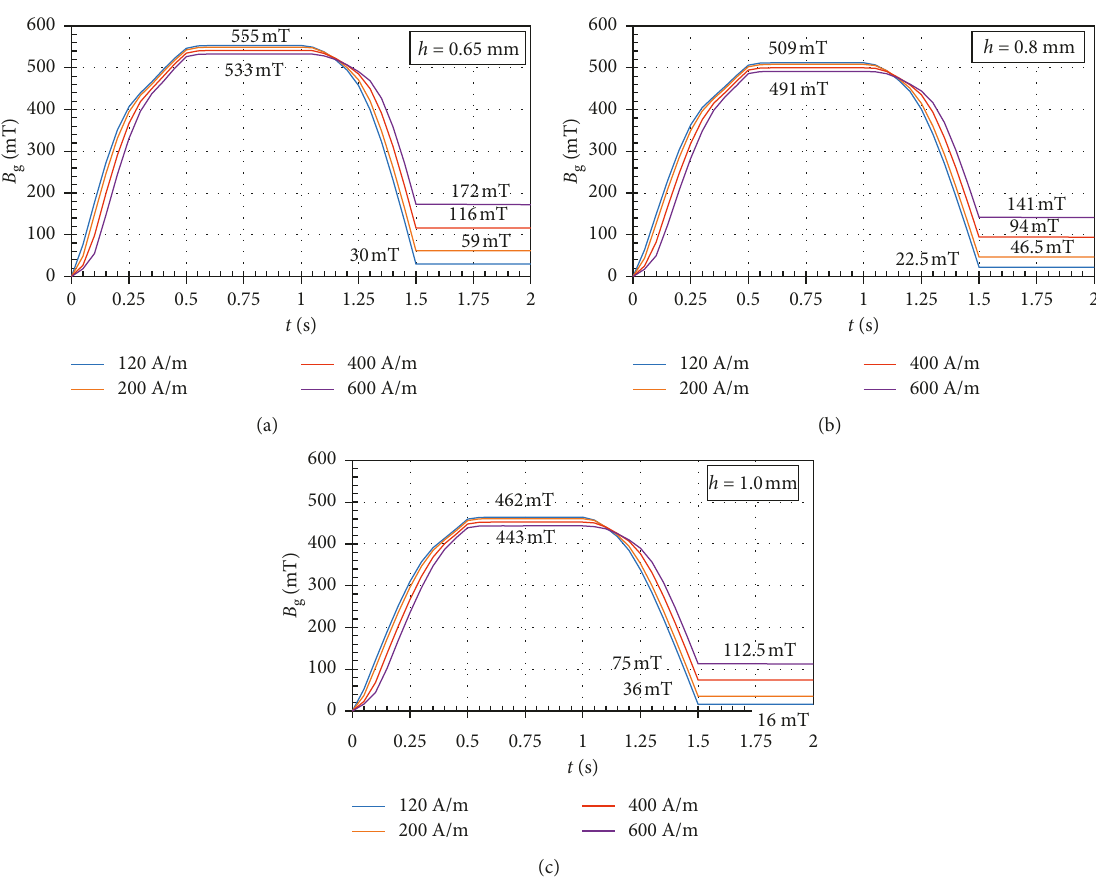
Figure 22: Influence of gap height and coercivity on magnetic flux density. (a) h � 0.65mm. (b) h � 0.8mm. (c) h � 1.0mm.